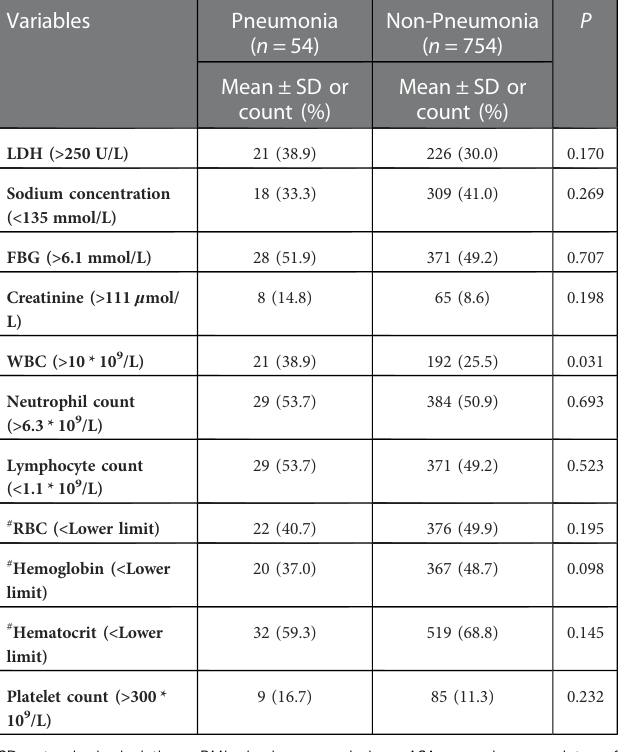
TABLE 1 Univariate analysis of variables between pneumonia and non- pneumonia patients.